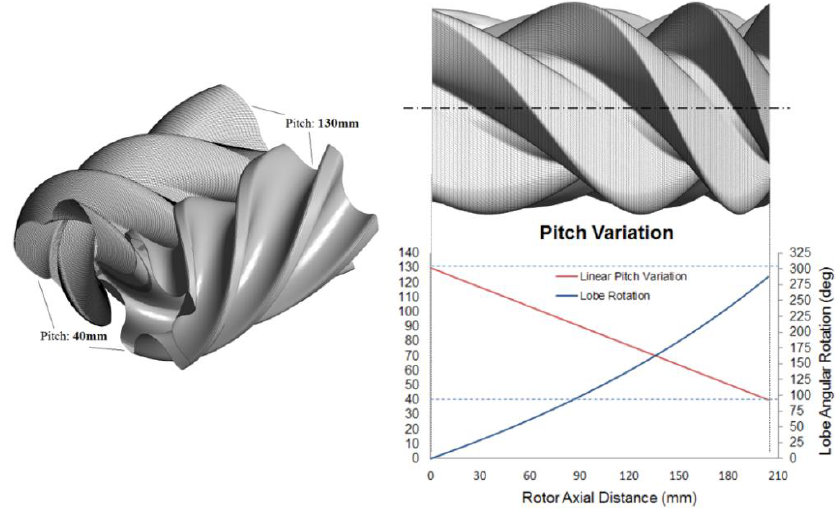
Figure 8. Variable lead screw rotor grid with 3/5 ‘N’ profile ([1,7], Video S1).